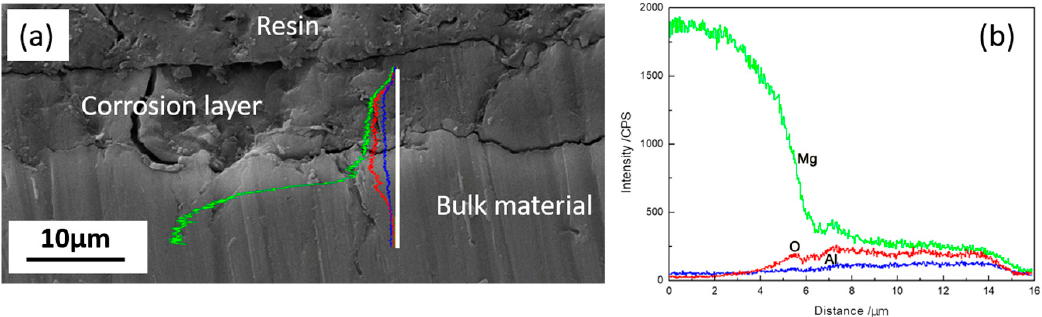
Figure 8. The cross-section of sample immersed in HA solution for 48 h ( a ) and the corresponding linear EDX spectra ( b ).